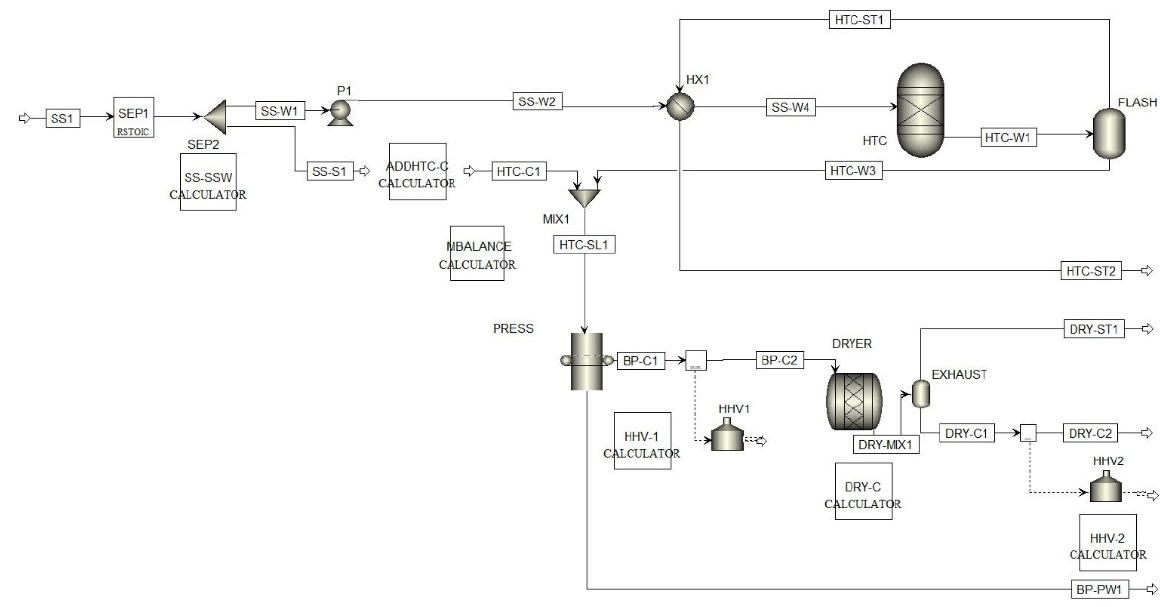
Figure A1. Aspen Plus flowsheet of heat integrated HTC and subsequent drying including the used calculator blocks to manipulate unit operations. Table A2. Ultimate and proximate analysis of the NC input stream SS 1 in %. Table A2. Pseudo-reactions in RSTOIC unit operations for NC component handling regarding sep- aration ( SEP 1) and drying ( DRYER ).